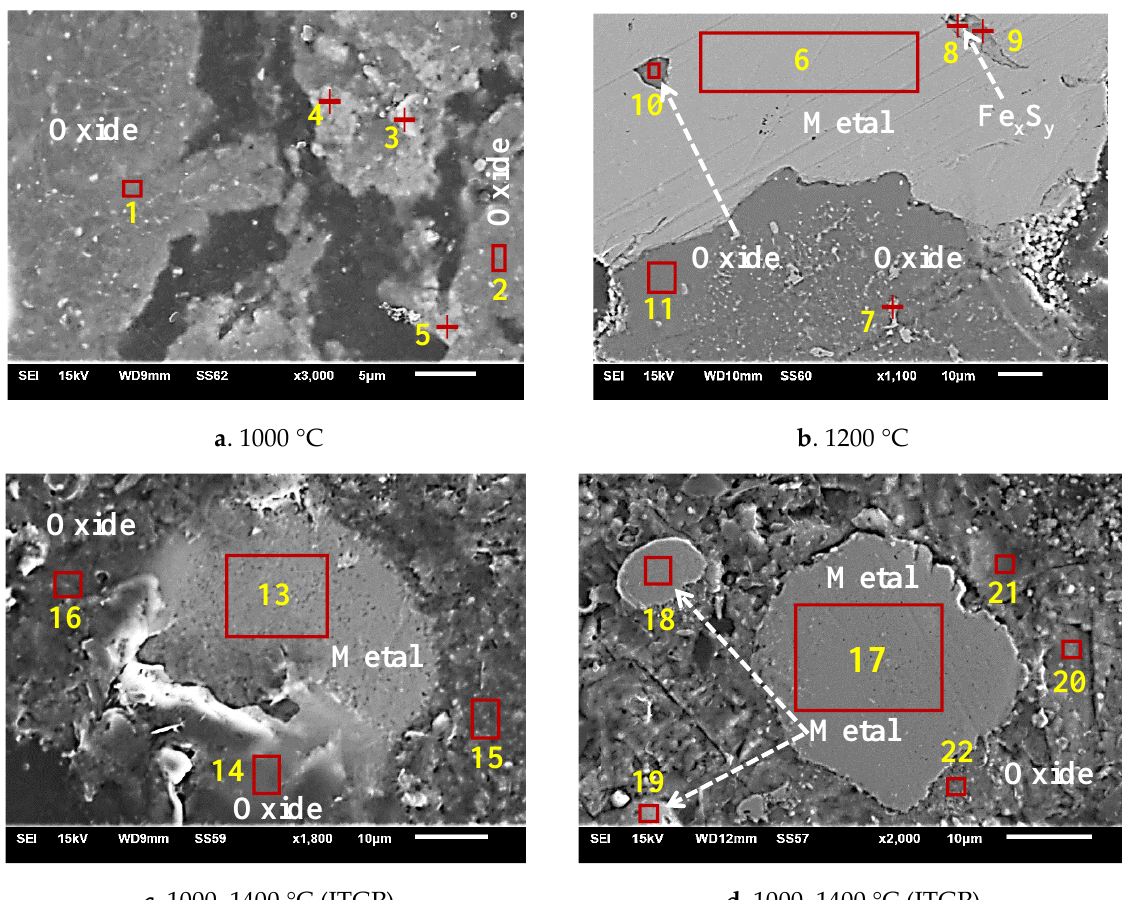
Figure 8. SEM images of unroasted natrojarosite residue after carbothermic reduction at different temperatures; ITGP = isothermal temperature gradient profile.